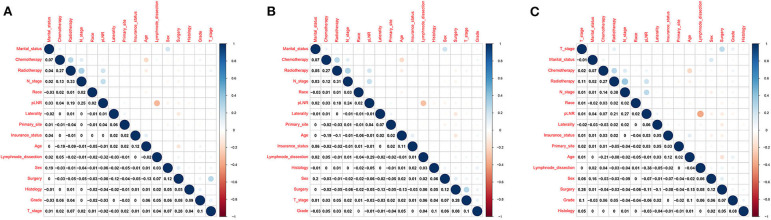
Correlations between variables in the overall dataset. (A) The training set (B) and the validation set (C).